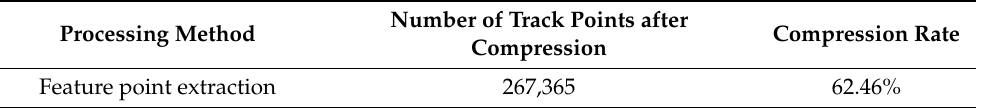
Table 5. Trajectory simplicity improvement results.